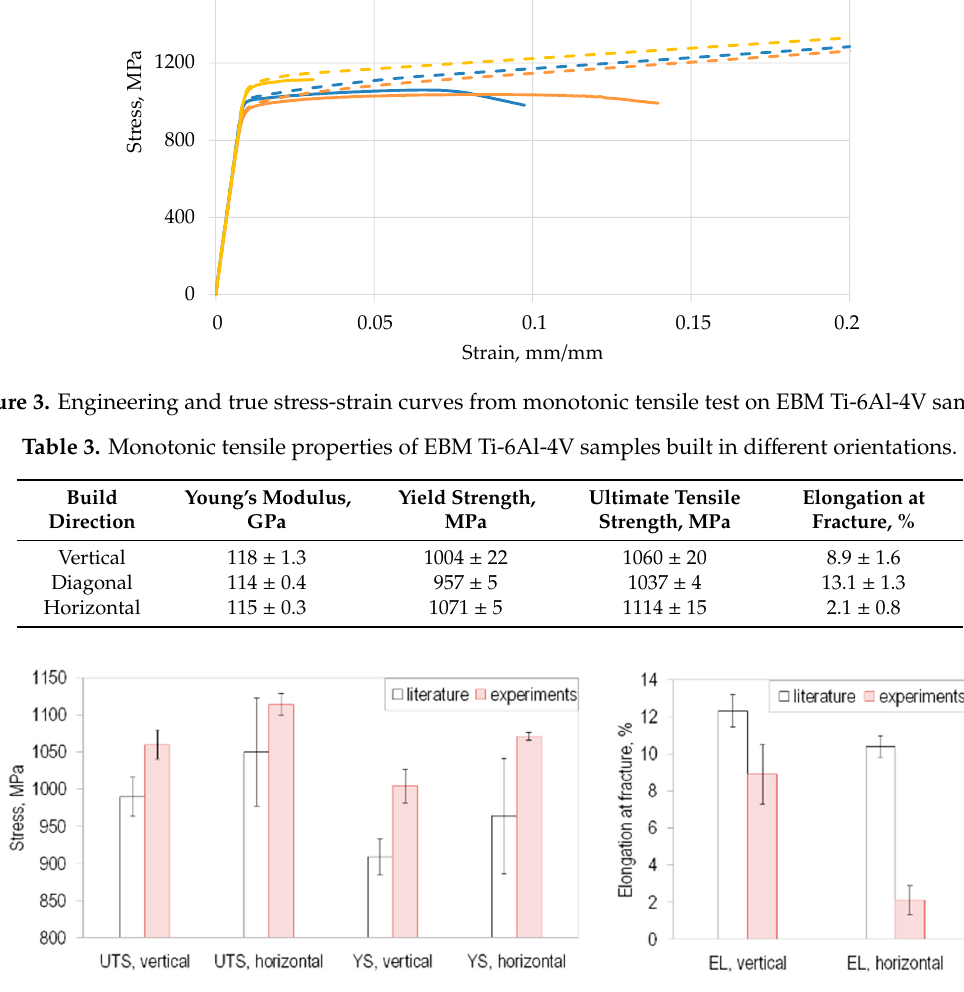
Figure 4. Experimentally determined tensile properties (ultimate tensile strength—UTS, yield strength—YS, elongation at fracture—EL) for vertically and horizontally built specimens compared to literature data of EBM manufactured Ti-6Al-4V machined specimens